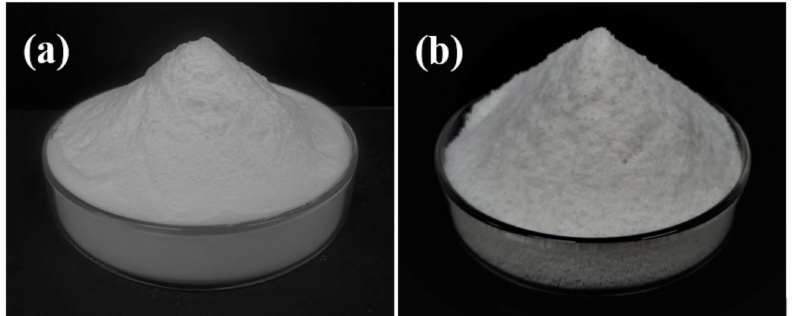
Figure 2. Macrographs of appearance for raw and agglomerated PPSPs: ( a ) raw PPSP and ( b )